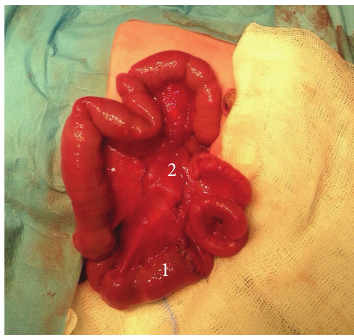
Figure 6: 1, end-to-end jejunoileal anastomosis. 2, ileocecal valve.